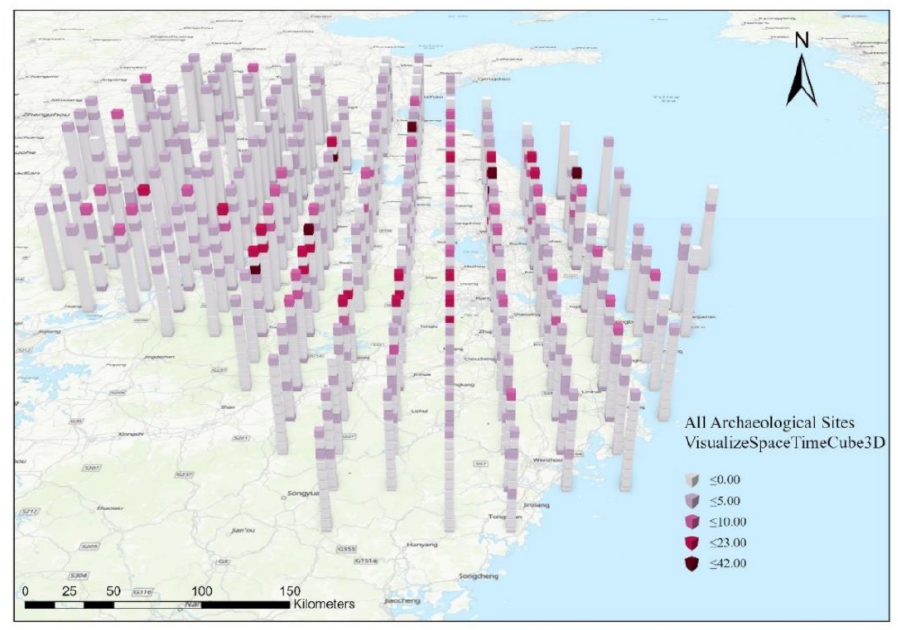
Figure 9. The space-time cube expression of Archaeological Sites in the study